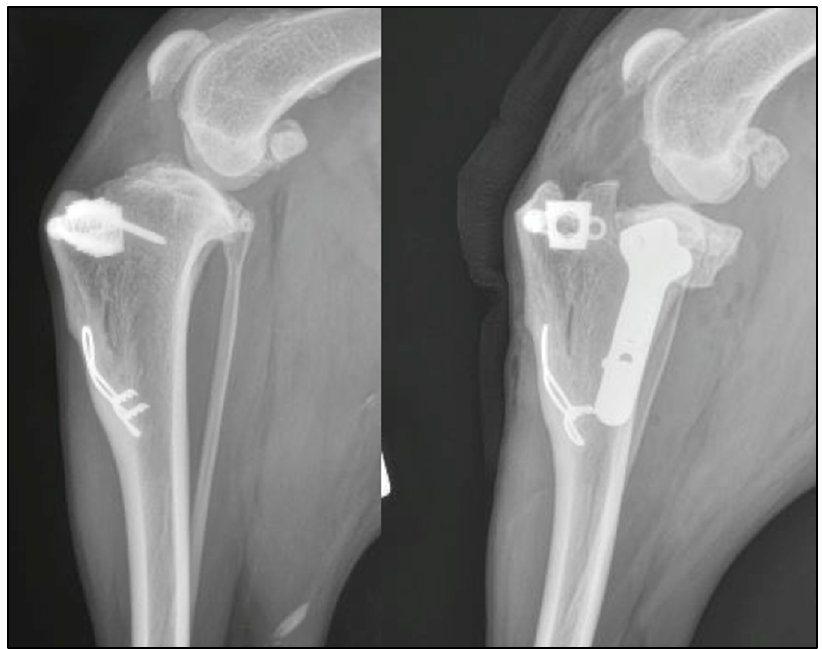
Figure 1. Case 7: pre- and post-operative mediolateral radiographs of the stifle. The caudal screw of the MMT cage was removed and a TPLO performed caudal to the implant.